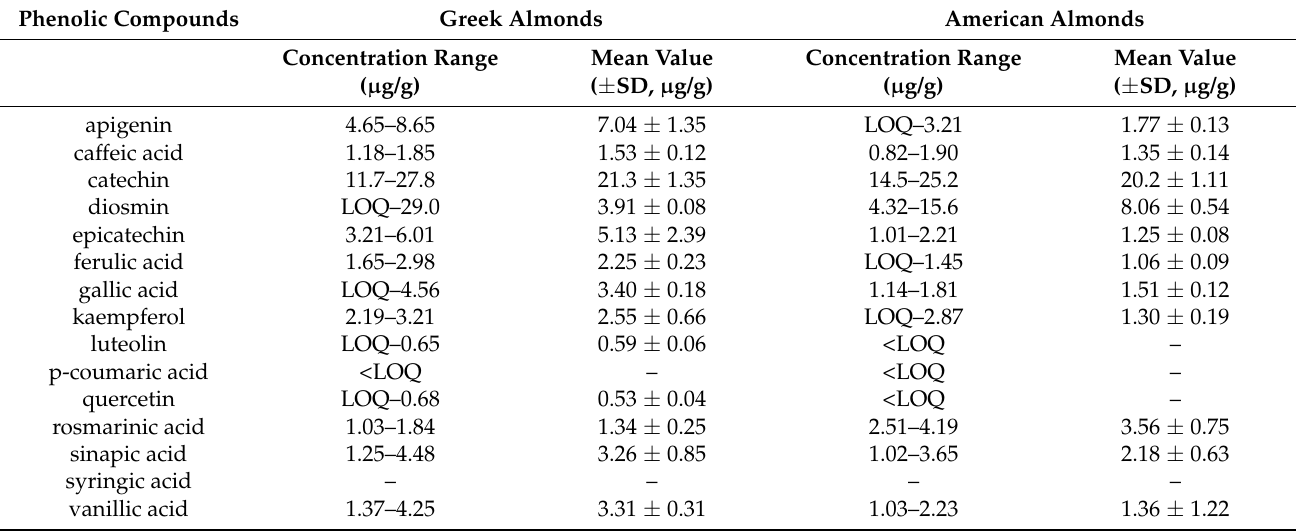
Table 1. Phenolic compounds’ quantification results in Greek and American almonds (samples analyzed in triplicate, n = 3). Phenolic Compounds Greek